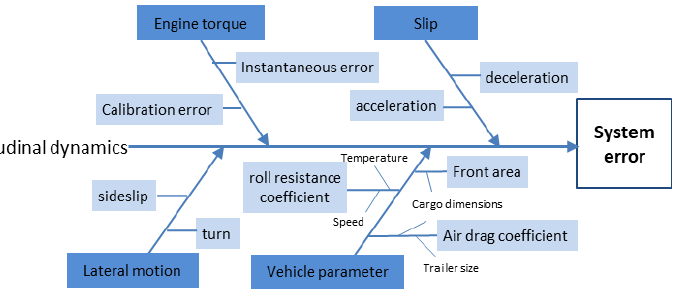
Figure 8. Source of system error.